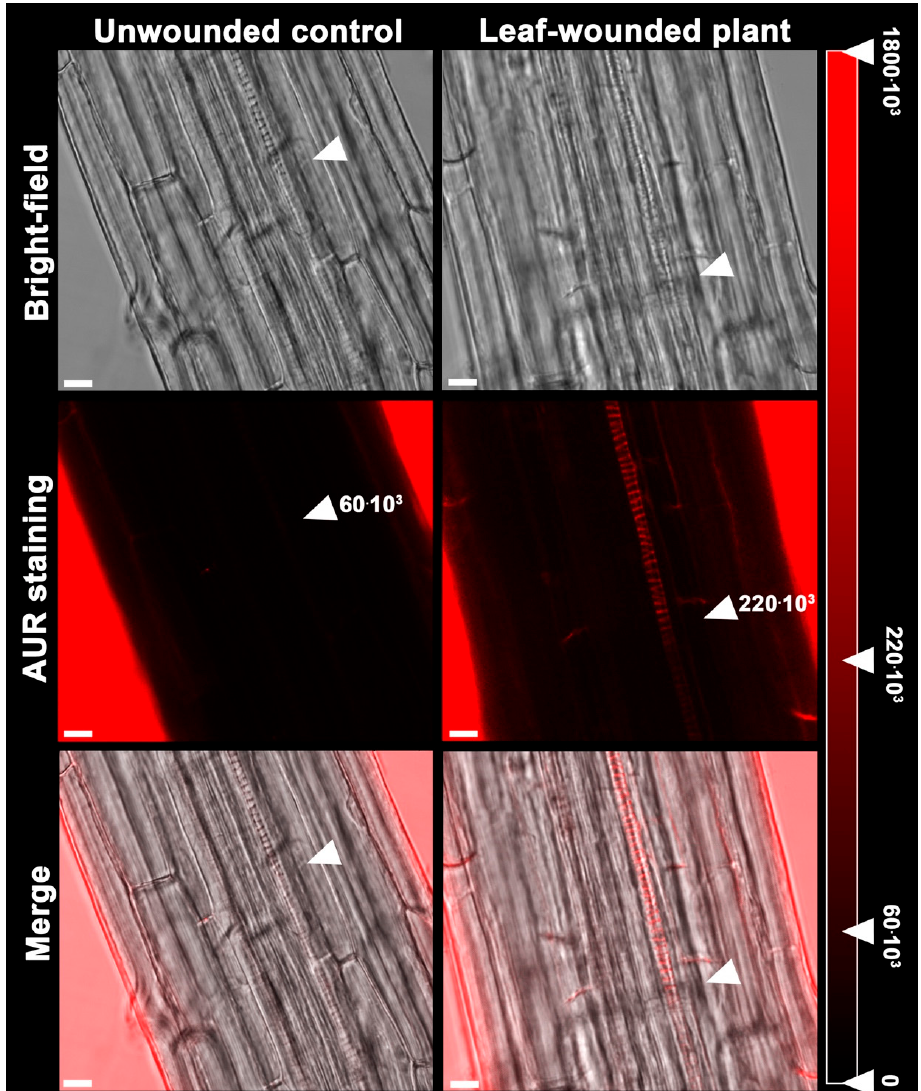
Figure 4. In situ H 2 O 2 detection by analysis under LSCM after AUR staining of roots from 7-day-old unwounded control and leaf-wounded seedlings 6 h after injury. The corresponding bright-field and overlay images are shown. Micrographs show the root zone corresponding to the site of appearance of the first protoxylem cell with fully developed secondary cell wall thickenings (arrows) and have been taken at the level of the central root section. Images are representative of those obtained from ten seedlings from five independent experiments. In the red degrading scale, the average values of fluorescence intensity, measured as the sum of the pixels of each 65 µm 2 rectangle, are indicated for unwounded control and leaf-wounded plants, and these were 60 × 10 3 ± 19 × 10 3 and 220 × 10 3 ± 38 × 10 3 , respectively (mean values ± SD; n = 25). The maximum pixel sum for a completely saturated square was approximately 1800 × 10 3 . Bar: 10 µm.